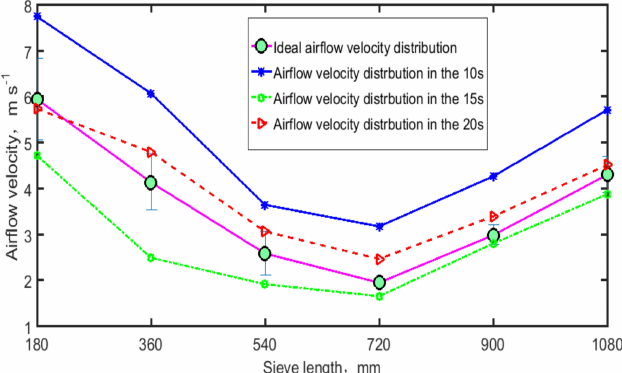
Figure 11. Variation of airflow velocity distribution above the sieve within the first 20